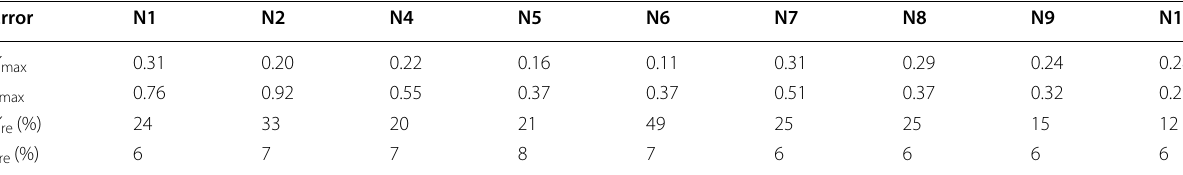
Table 2 Kriging prediction errors at different positions